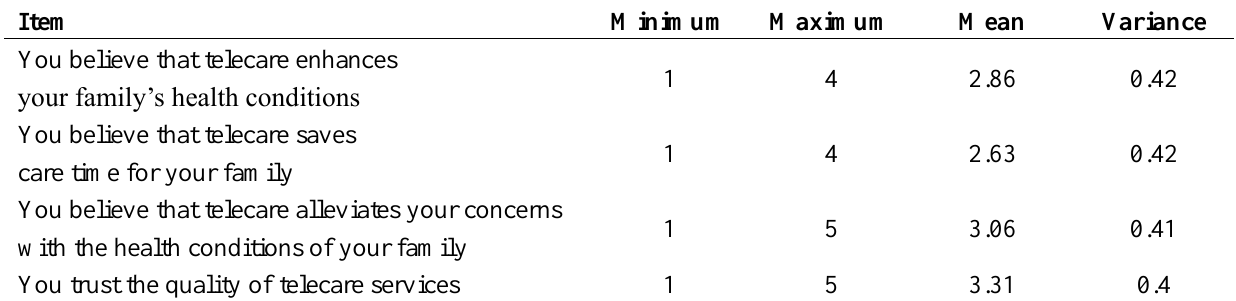
Table 2. Descriptive statistics of families’ trust in telecare.